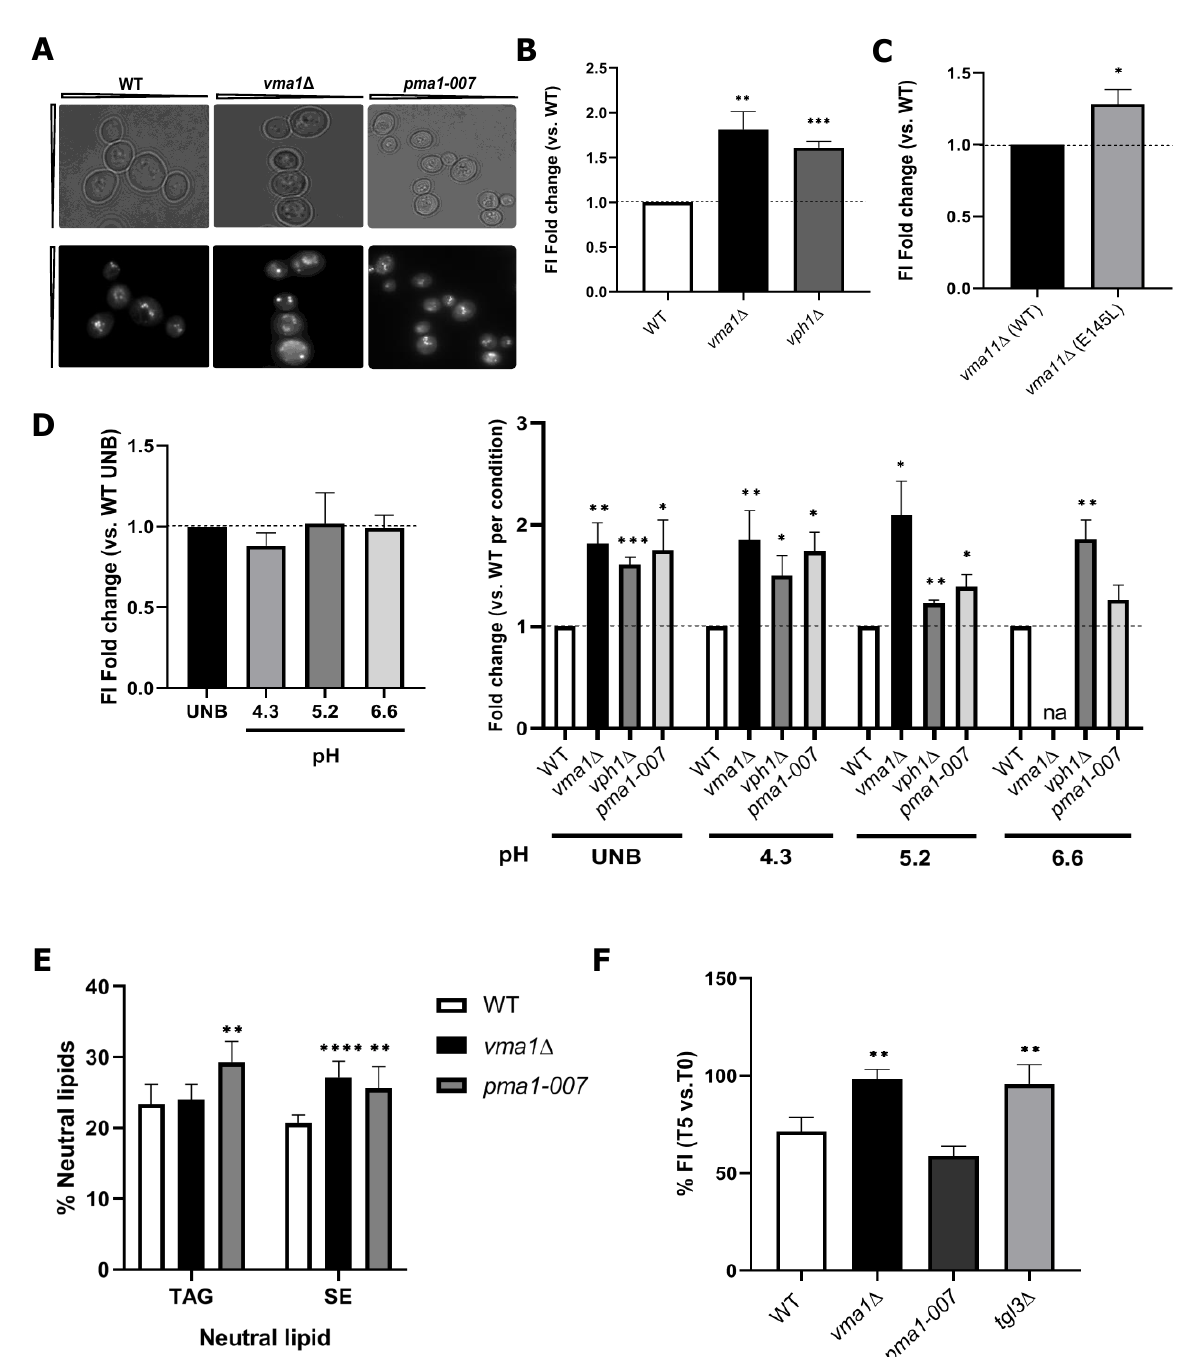
Figure 3. Deregulation of intracellular pH due to loss of V-ATPase and Pma1 activities is associated with perturbed LD metabolism. ( A ) LD staining of WT, vma1 Δ , and pma1-007 cells with BODIPY493/503 and analysis by fluorescence microscopy. Cells were grown as described in Figure 1B. Scale bar, 2 µm. (B and C) The vph1 Δ mutant, and vma11 Δ cells carrying VMA11 WT or the VMA11 E145L mutation, have higher NL content. Growth conditions and BODIPY493/503-associated FI measurements are described in Figure 1B. For each strain, shown are FI fold changes vs. WT ( B ), or normalized to vma11 Δ cells expressing VMA11 WT allele ( C ). ( D ) Intracellular acidification upon deletion of VMA1 or VPH1 , and pma1-007 mutation leads to higher LD induction, irrespective of extracellular pH. Cells were grown in SC unbuffered (UNB) or buffered to low, medium, and high pH (pH 4.3, 5.2, and 6.6, respectively) media, as described in (A), and fluorescence intensity analysis by flow cytometry is described in (B). For each condition, shown are FI fold changes vs. WT UNB. na—non-applicable. ( E ) V-ATPase and pma1-007 mutants have increased neutral lipid content. Cells of indicated